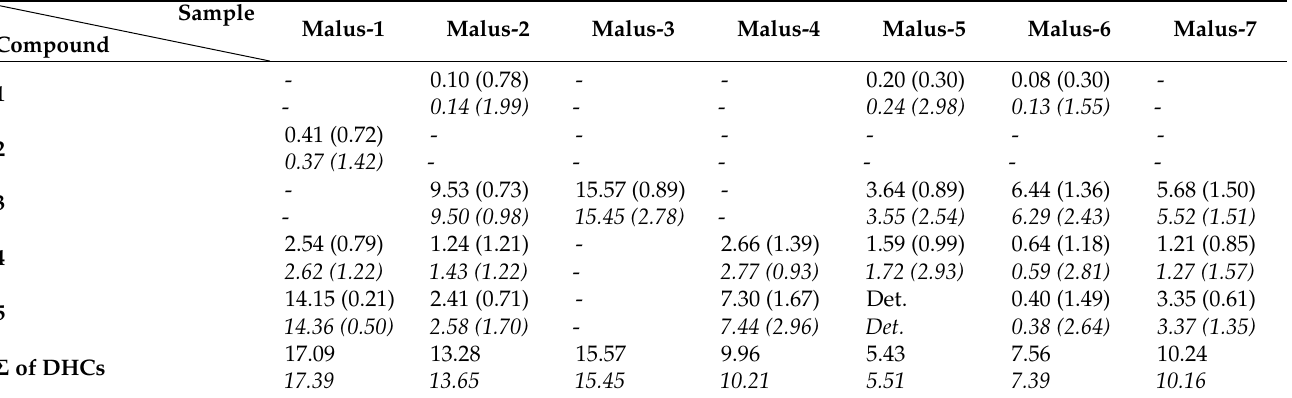
Table 2. The content of DHCs in different Malus species as determined by SFC (plain text) and CE (italics). Mean values are expressed as mg per g of dried biomaterial with corresponding relative standard deviation in parentheses. Assignment of compounds as in Figure